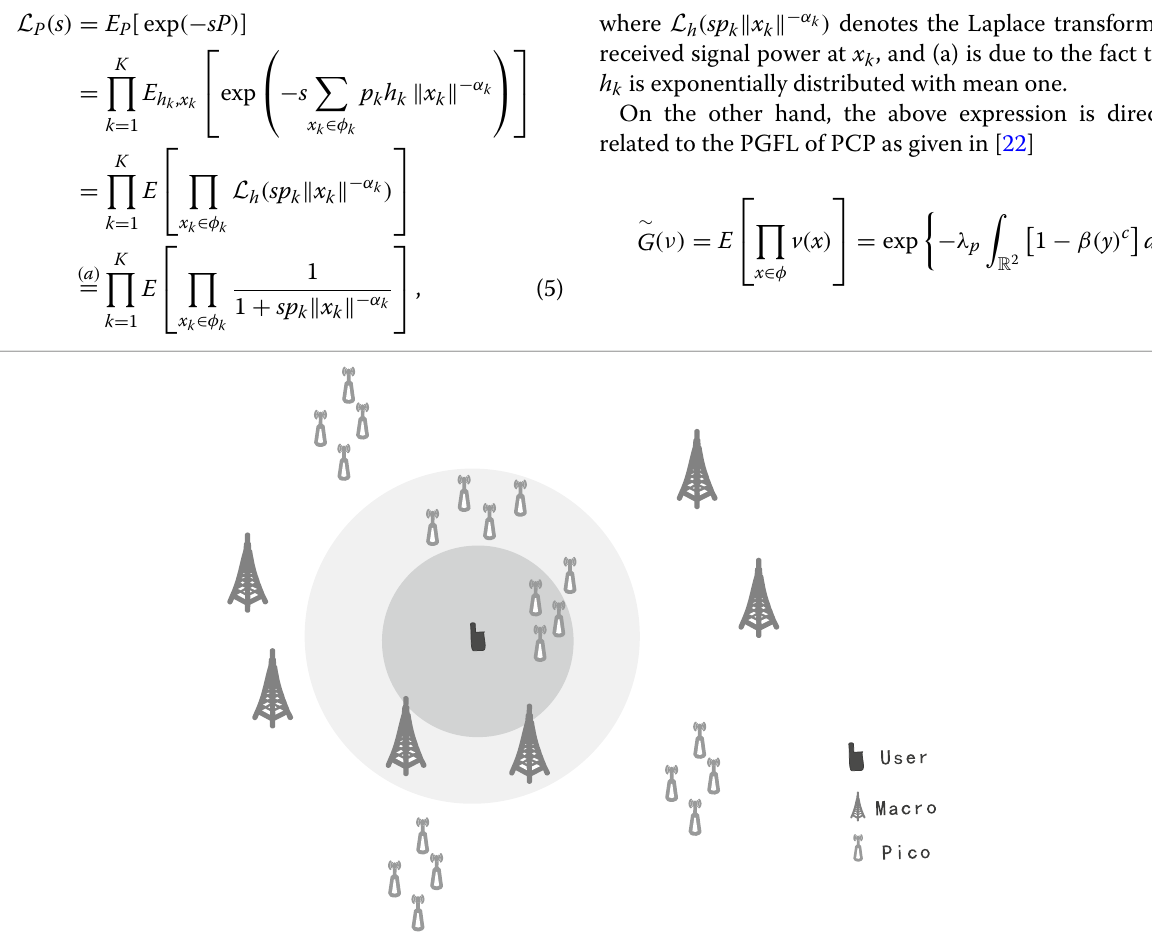
Fig. 2 A typical user is served by macro and pico BSs, where a small circle and a large circle denote pico BSs and macro BSs cooperative areas,